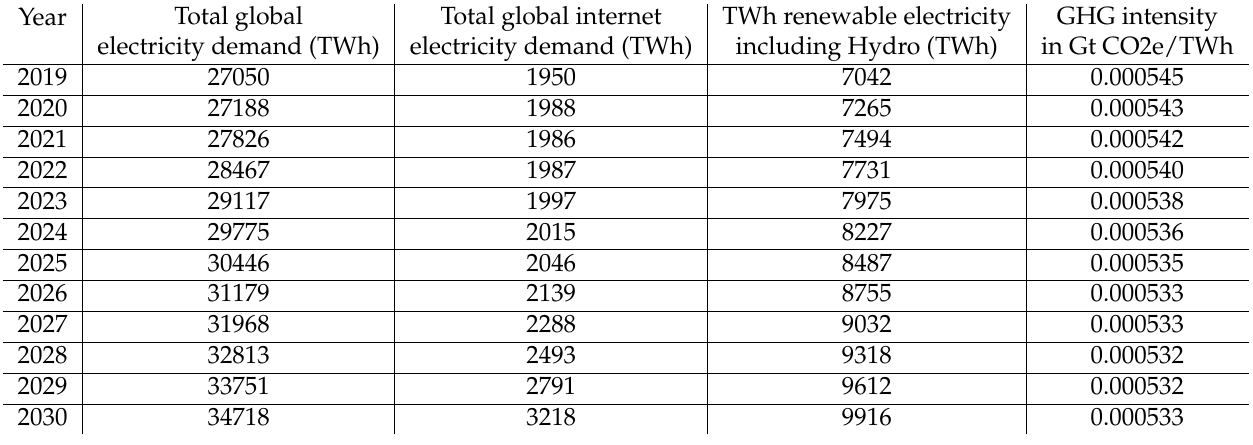
Table 1. Global Electricity demand and average GHG intensity 2019 to 2030.